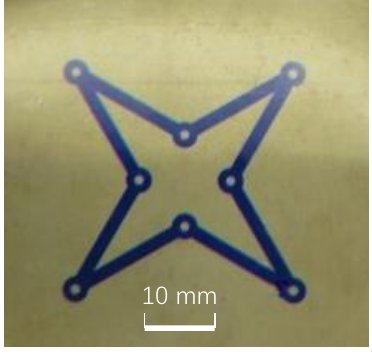
Figure 5. Beryllium bronze sheet with photo-sensory membrane.